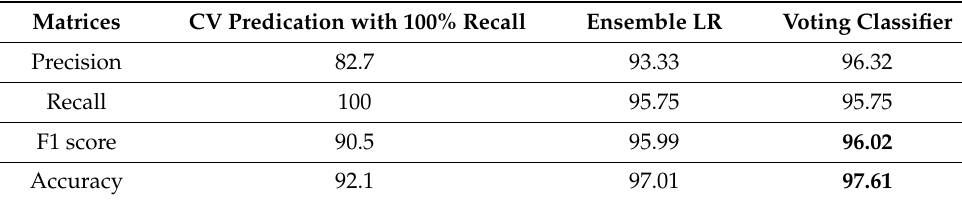
Table 5. Performance comparison of Ensemble LR, voting classifier (CV), and voting classifier prediction with 100%